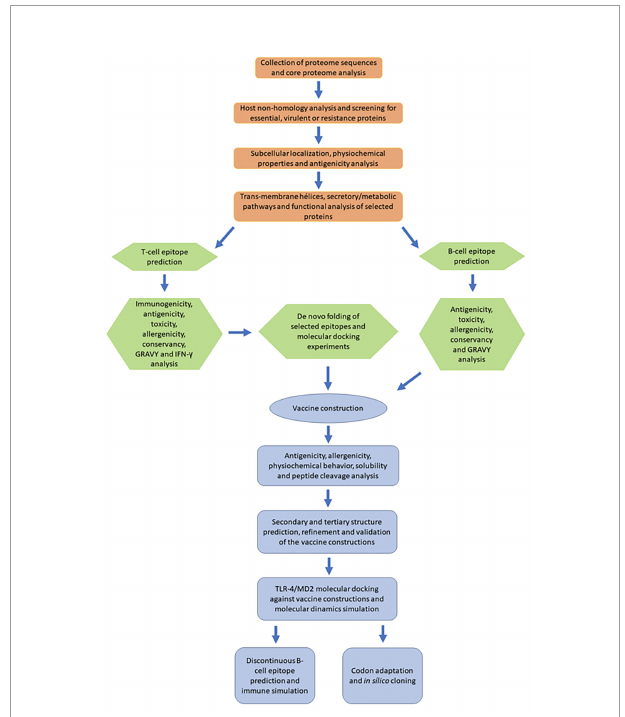
FIGURE 1 | A schematic fl owchart diagram showing the procedure used in the current study. Orange: subtractive proteome analysis. Green: identi fi cation, characterization, and selection of peptide epitopes. Blue: construction and analysis of the multiepitope